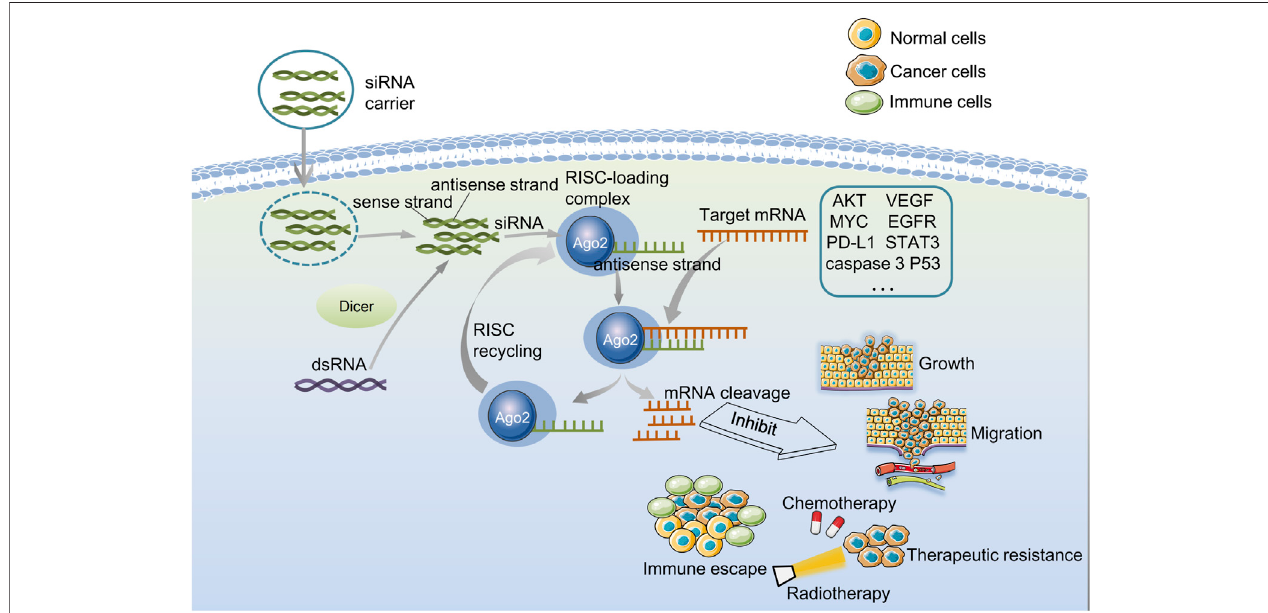
FIGURE 1 | Biological characterization of gene silenced by endogenous siRNA and exogenous siRNA. Dicer cleaves the dsRNA for the endogenous pathway and gives rise to siRNAs. Then siRNA molecule is incorporated into an RNA-induced silencing complex (RISC) in the cell cytoplasm, and the sense strand is cleaved by Argonaute-2. Next, the antisense strand of the activated RISC binds to and cleaves the target mRNA that is complementary to the antisense strand, preventing translation and thereby silencing gene expression. The activated RISC can be recycled, after several cycles of synthesis-cutting, the role of RNAi is continuously ampli fi ed, and fi nally, the target mRNA is completely degraded. For exogenous pathways, siRNA-carriers deliver siRNAs to glioma cells, and siRNA can be directly loaded into RISC without pre-treatment with the dicer enzyme. siRNA can silence cancer-related genes, thereby inhibiting cell growth and migration, reducing drug resistance, and improving anti-tumor